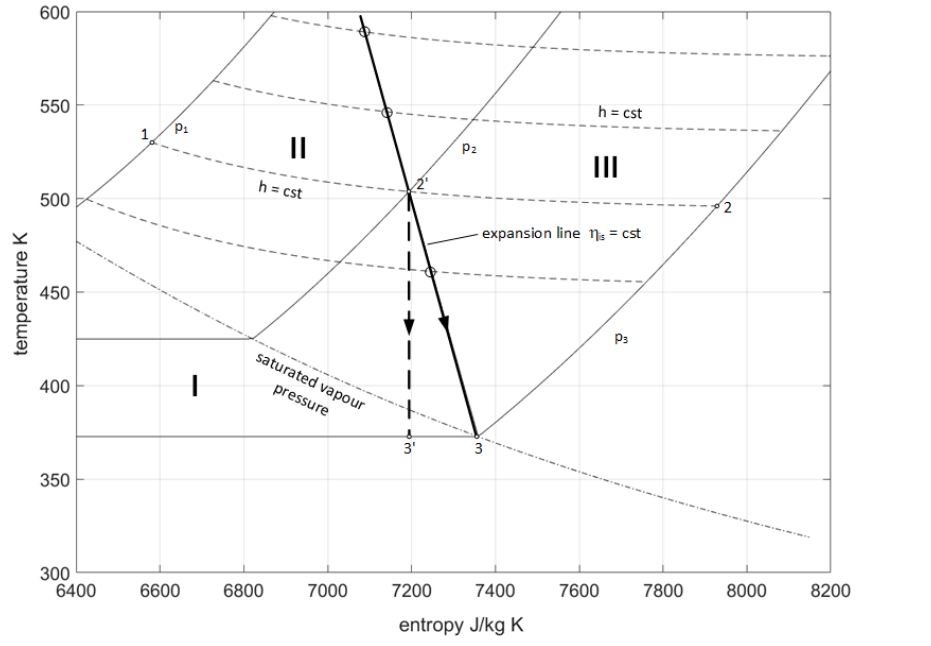
Figure 2. Graphical representation of the expansion line for a constant turbine efficiency η is